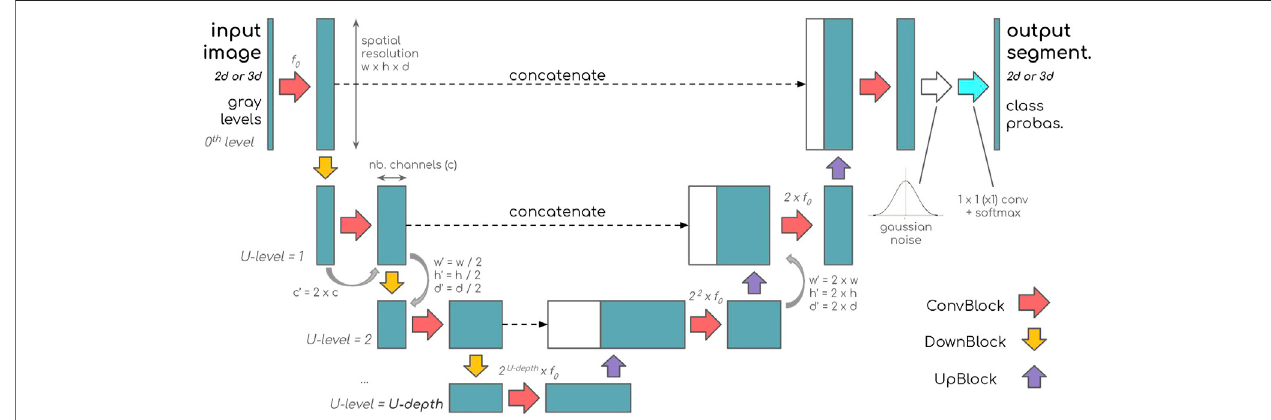
FIGURE 1 | Modular U-Net: a generalization of the U-Net architecture.